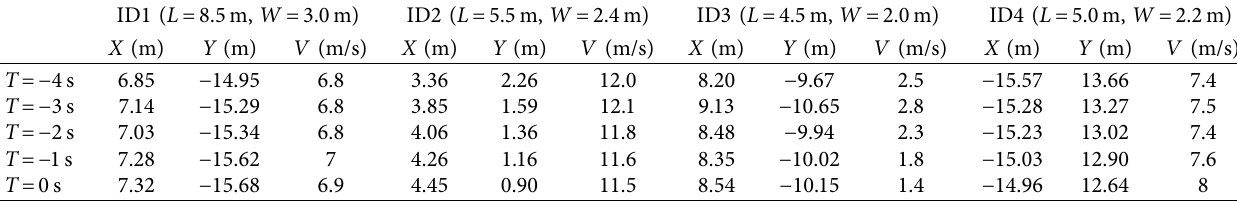
Table 2: The historical time-series data of the target vehicle state input into the Attention-BiLSTM model.